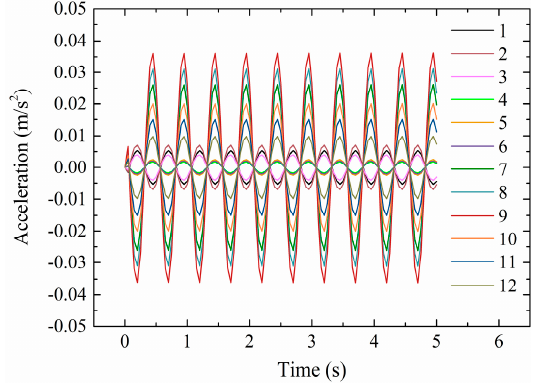
Figure 6. Acceleration response of case 1 in the beam–column connection.